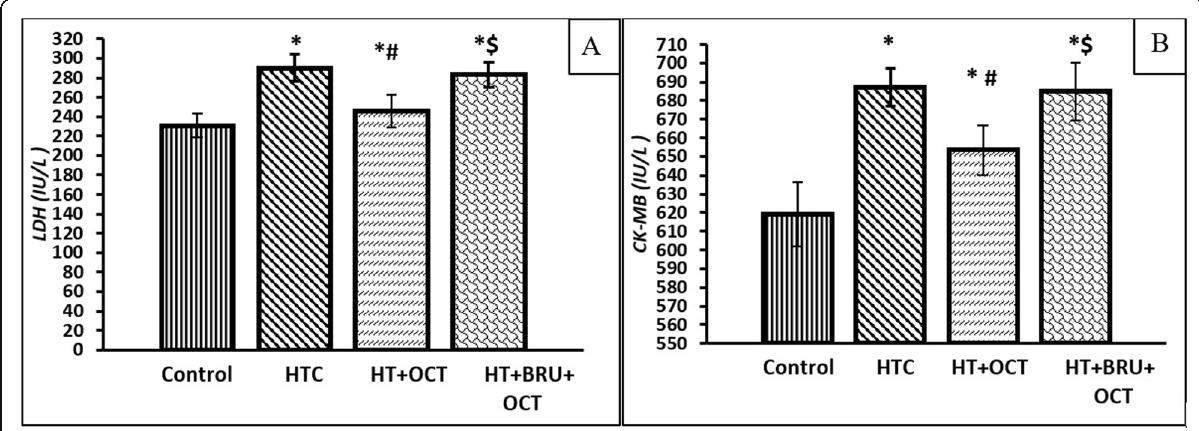
Fig. 3 Effect of octreotide on a LDH and b CK-MB in coronary flux in rat hearts exposed to ischemia for 30 min and reperfusion for 120 min. n = 10 rats in each group. Data are represented as mean ± standard deviation. Significance ( P < 0.05): *significant when compared with the control group, # significant when compared with HTC group, $ significant when compared with